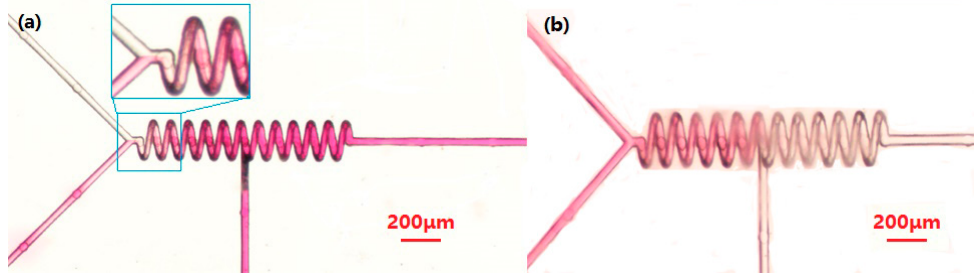
Figure 5. ( a ) Optical micrograph of mixing results of NaOH solution and phenolphthalein solution; ( b ) Mixing results after injecting diluted hydrochloric acid.